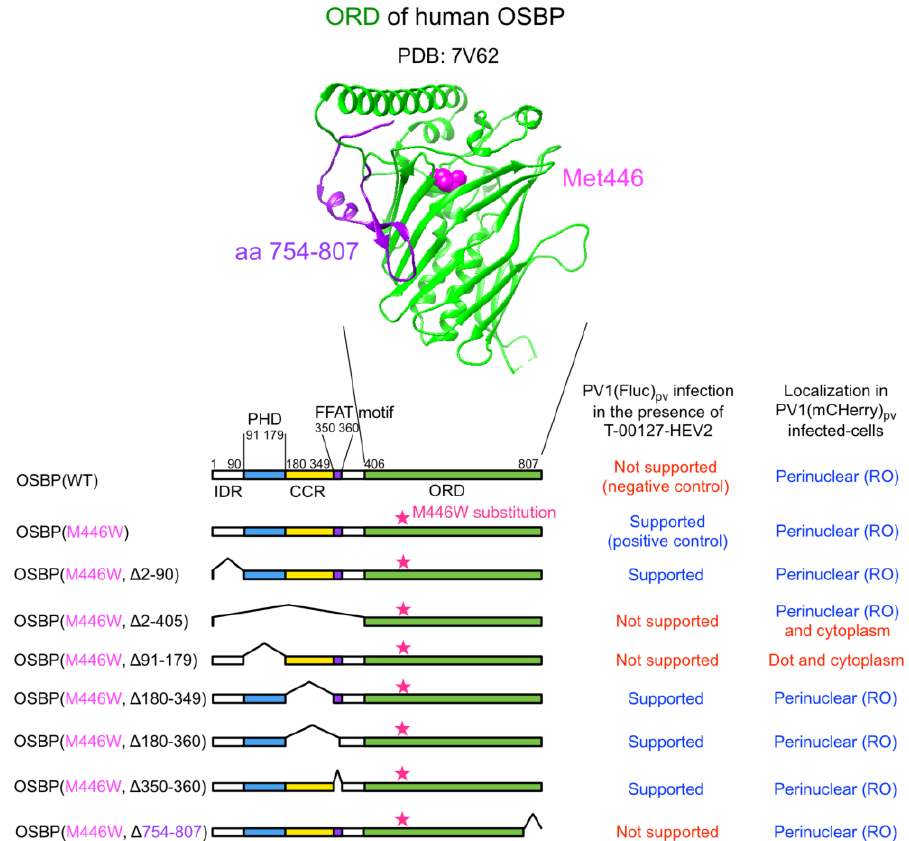
Figure 1. OSBP variants analyzed in this study. ( Upper ) A crystal structure of ligand-binding domain of human OSBP (PDB: 7V62). The M446 residue and a C-terminal region (aa 754–807) of the OSBP is highlighted in magenta and purple, respectively. ( Lower ) Domain organizations of OSBP variants analyzed in this study. The corresponding amino acid numbers of the domains are shown. IDR: intrinsically disordered region; PHD: pleckstrin homology domain; CCR: coiled-coil region; FFAT: two phenylalanines in an acidic tract.